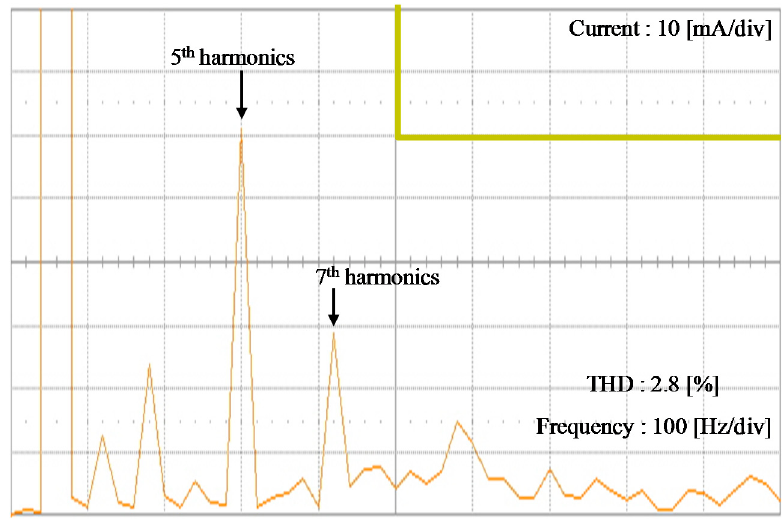
Figure 15. Fast Fourier transform (FFT) result for a -phase grid-side current.